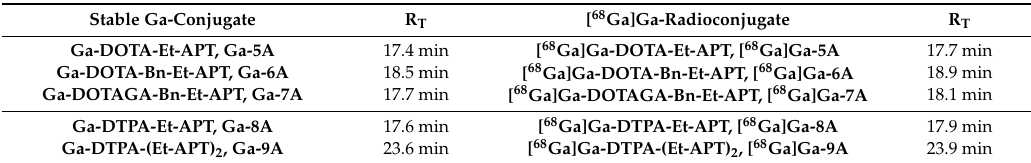
Table 1. Retention times (R T ) of stable gallium conjugates and [ 68 Ga]Ga ‐ radioconjugates of aprepitant ‐ ethylamine 2A .